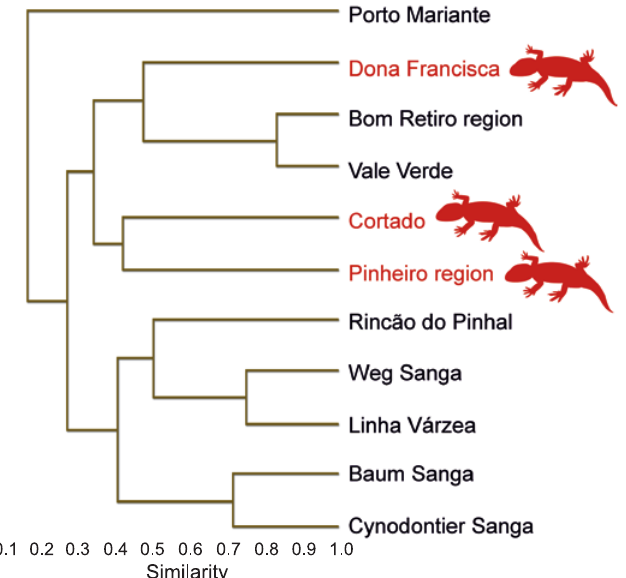
Fig. 5. Dendrogram from the updated dataset of Martinelli et al. (2017) of main localities of the state of Rio Grande do Sul yielding fossil tetrapods of the Dinodontosaurus Assemblage Zone. The silhouette represents the pre sence of Candelaria barbouri